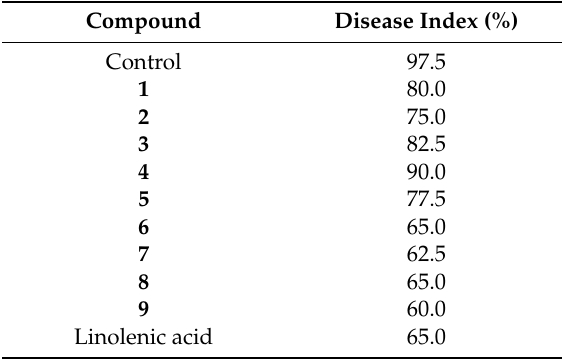
Table 2. The disease index after 10 days on citrus treated with tested compounds.